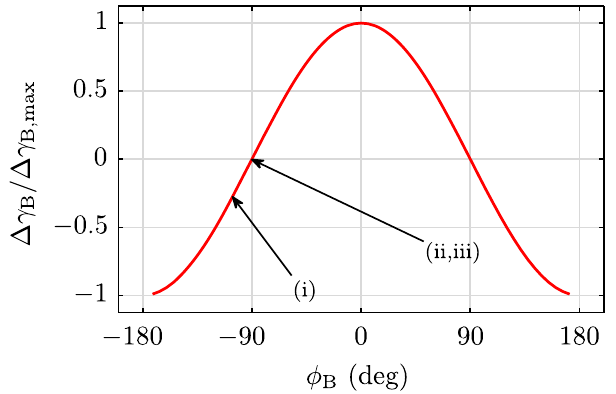
FIG. 4. Calculated energy gain of the buncher cavity in dependency of the phase. For case (i) a decelerating phase is set, determined by the analytic model for a curvature corrected focus at z ¼ 5 . 50 m. Cases (ii,iii) are set to the zero crossing and the amplitude is tuned for a bunch length minimum at the same focus position.